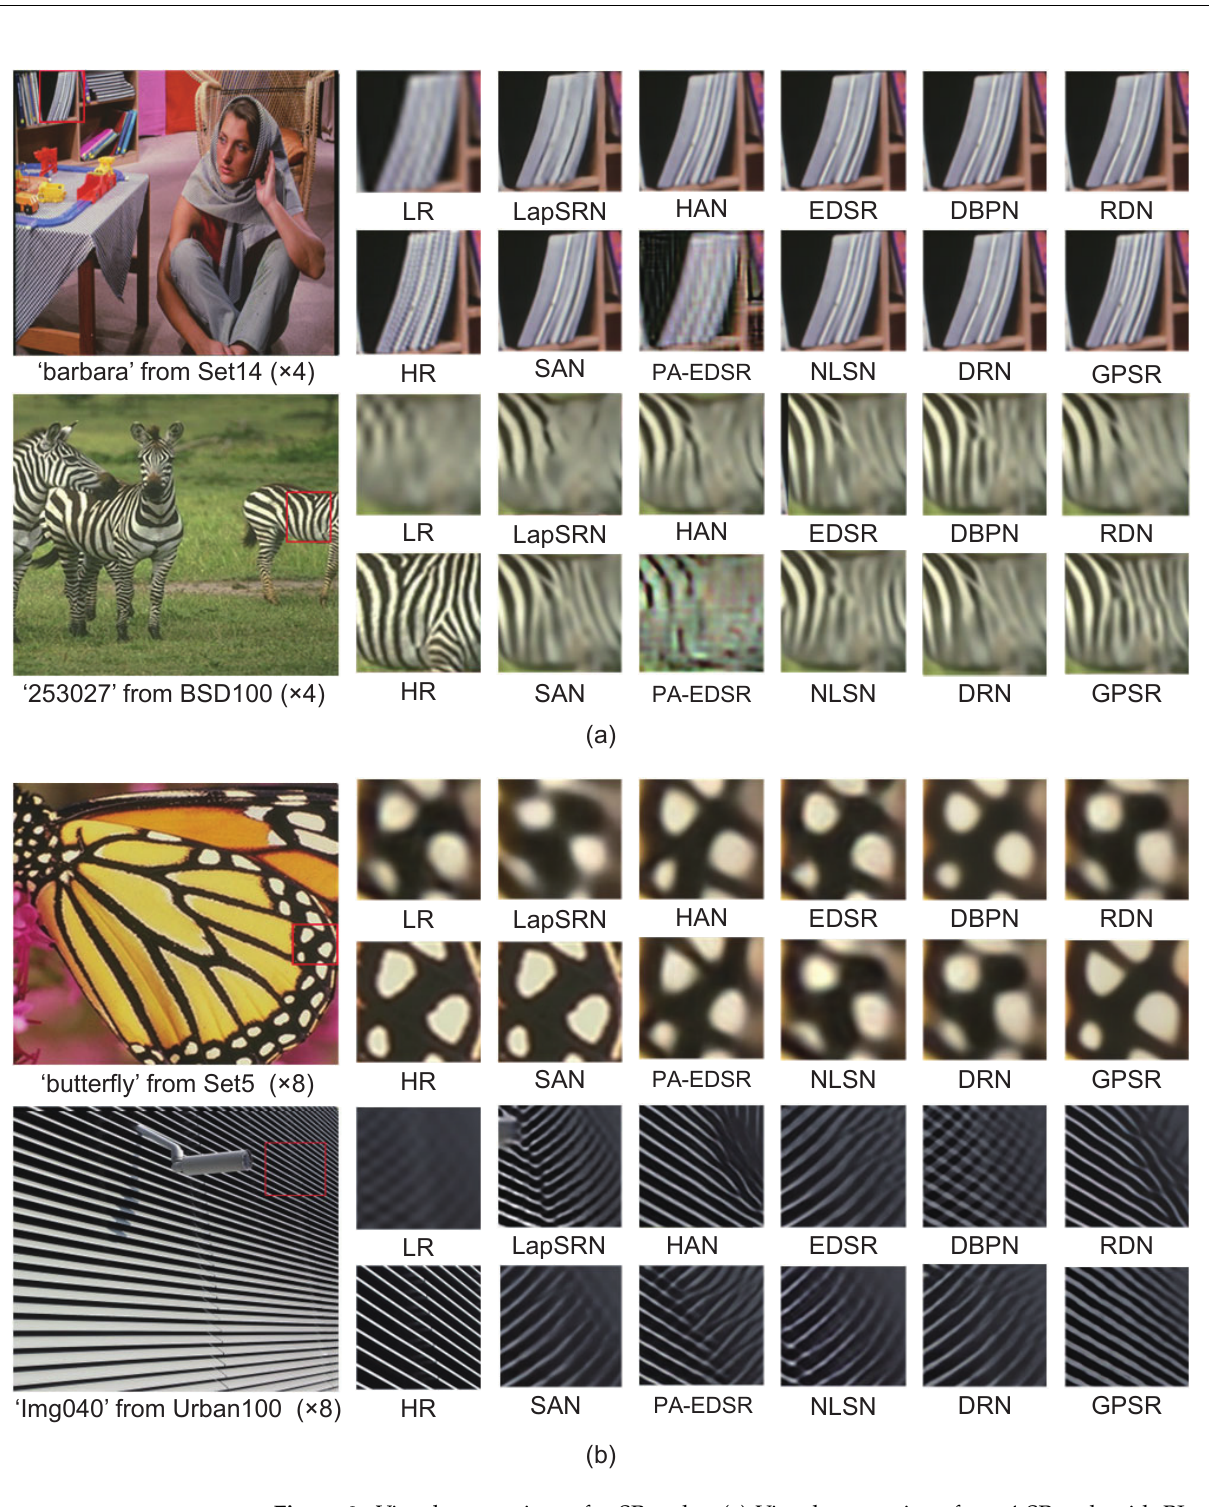
Figure 9. Visual comparisons for SR tasks. ( a ) Visual comparison for × 4 SR task with BI model on Set14 and BSD100 datasets. ( b ) Visual comparison for × 8 SR task with BI model on Set14 and Urban100